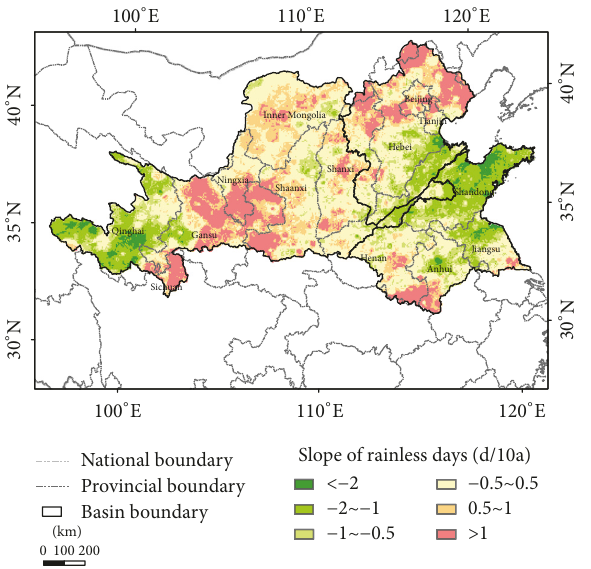
Figure 9: Rate of change in rainless days from 1982 to 2011.